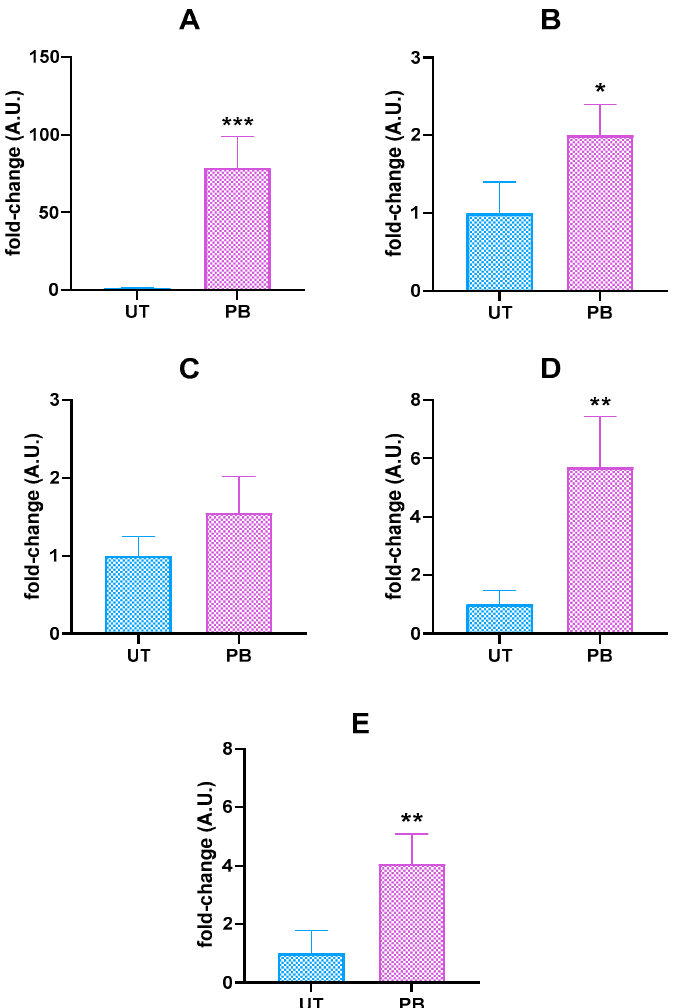
Figure 1. Hepatic CYP2B22 ( A ), 3A ( B ), 2C88 ( C ), 2C31 ( D ), and 2C42 ( E ) mRNA levels in untreated control (UT, n = 3) and phenobarbital-treated (PB, n = 4) cattle. Data (arithmetic means ± SD) are expressed as n -fold change (arbitrary units, A.U.) normalized to ∆∆ Ct mean value of β -actin ( ACTB , the chosen internal control gene, ICG), to which an arbitrary value of 1 was assigned. * p < 0.05; ** p < 0.01; *** p < 0.001 (unpaired t -test).